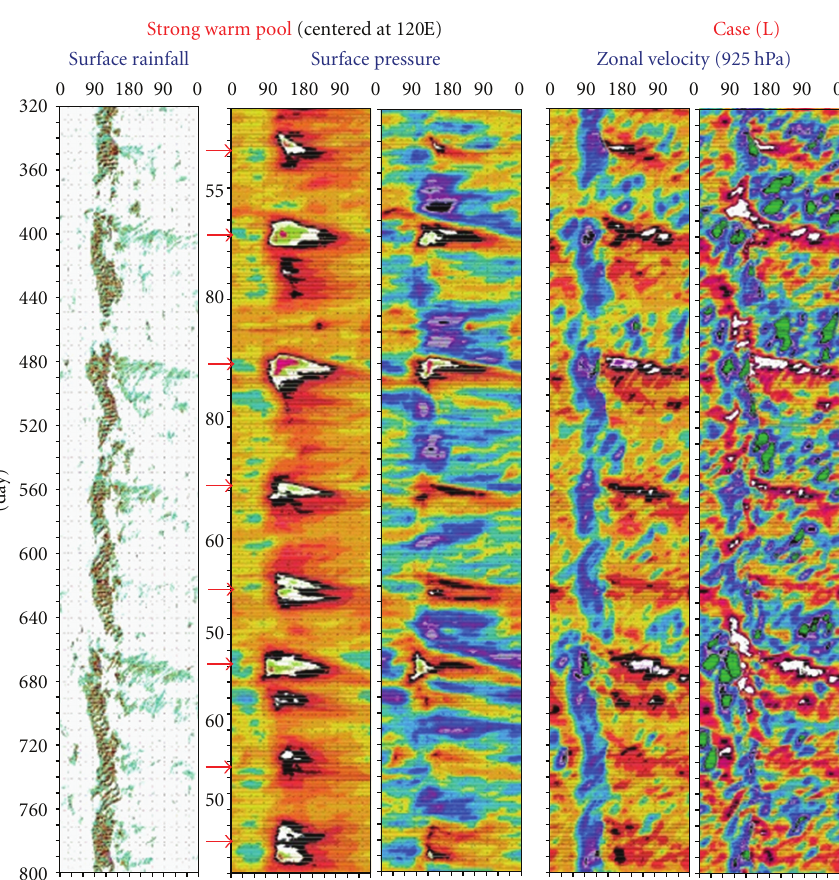
Figure 4: Same as Figure 2 but for case